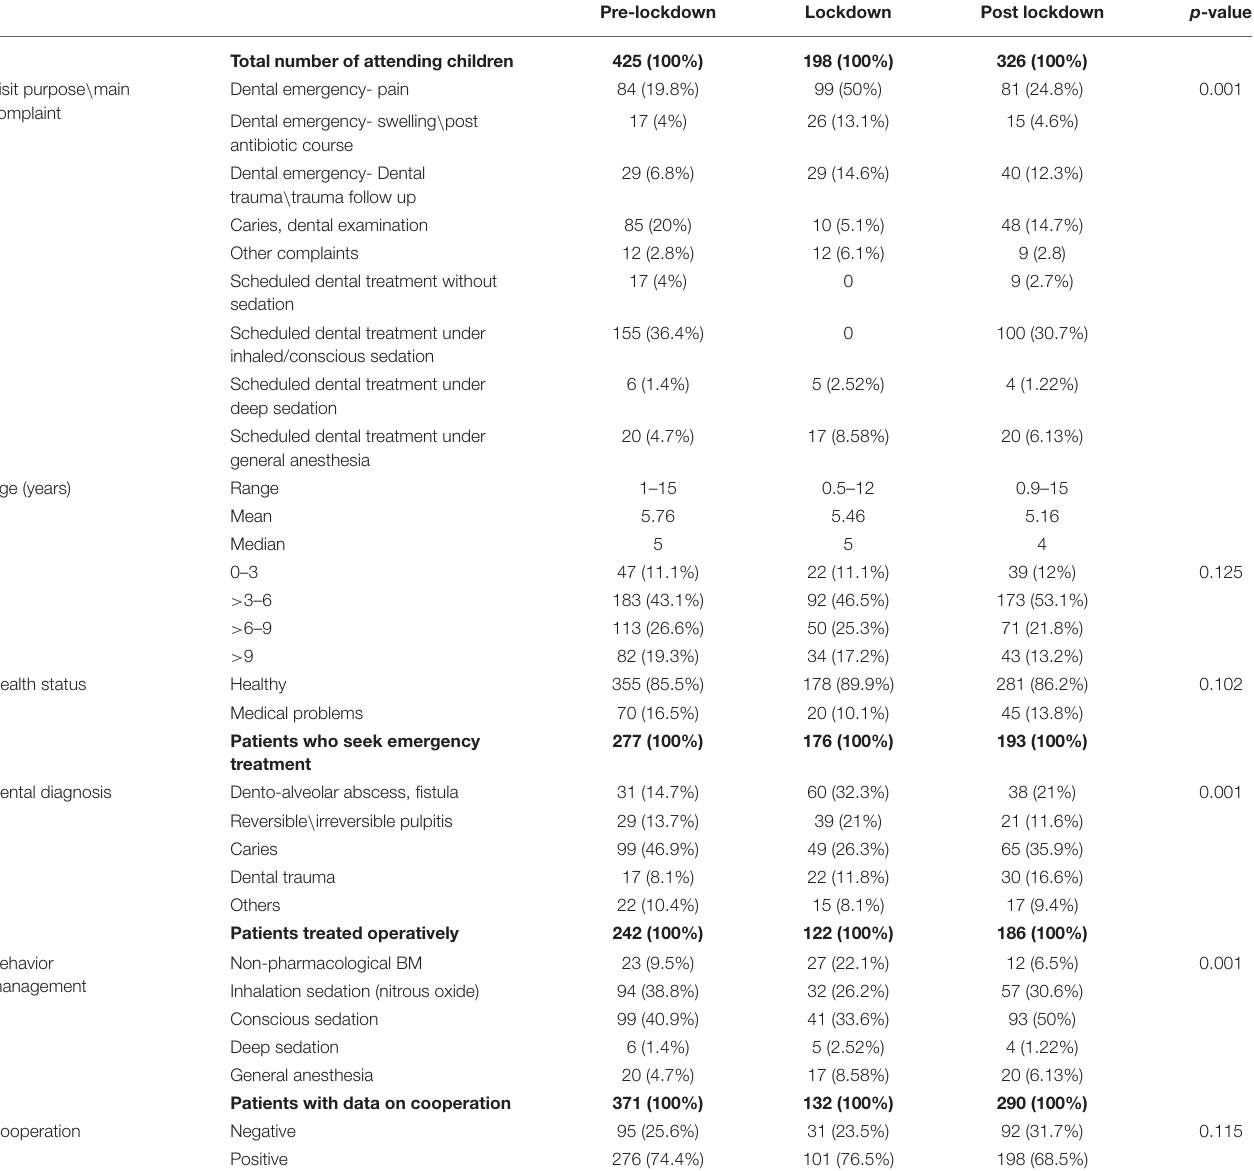
TABLE 1 | Patients’